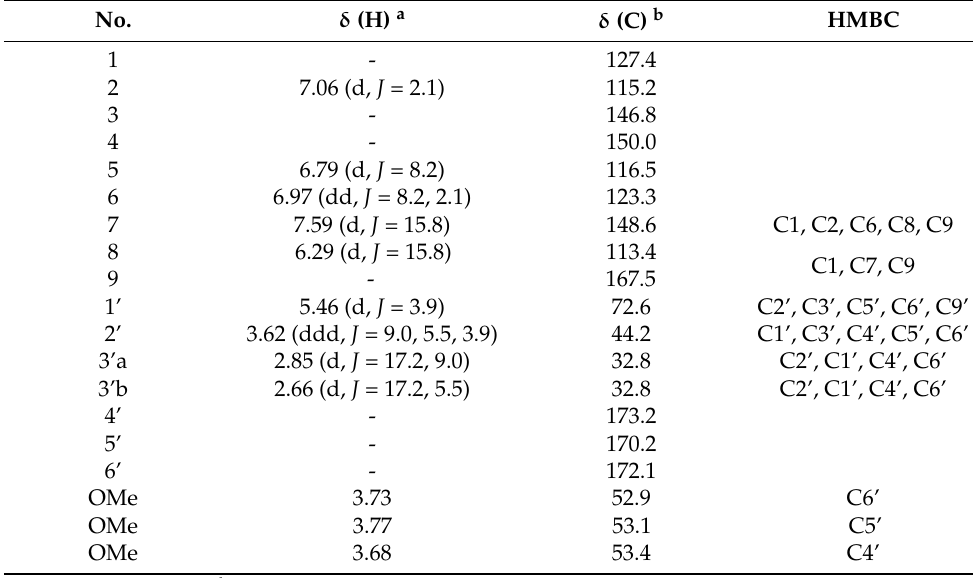
Table 1. 1 H- and 13 C-NMR data of 1 (in CD 3 OD; δ in ppm, J in Hz).